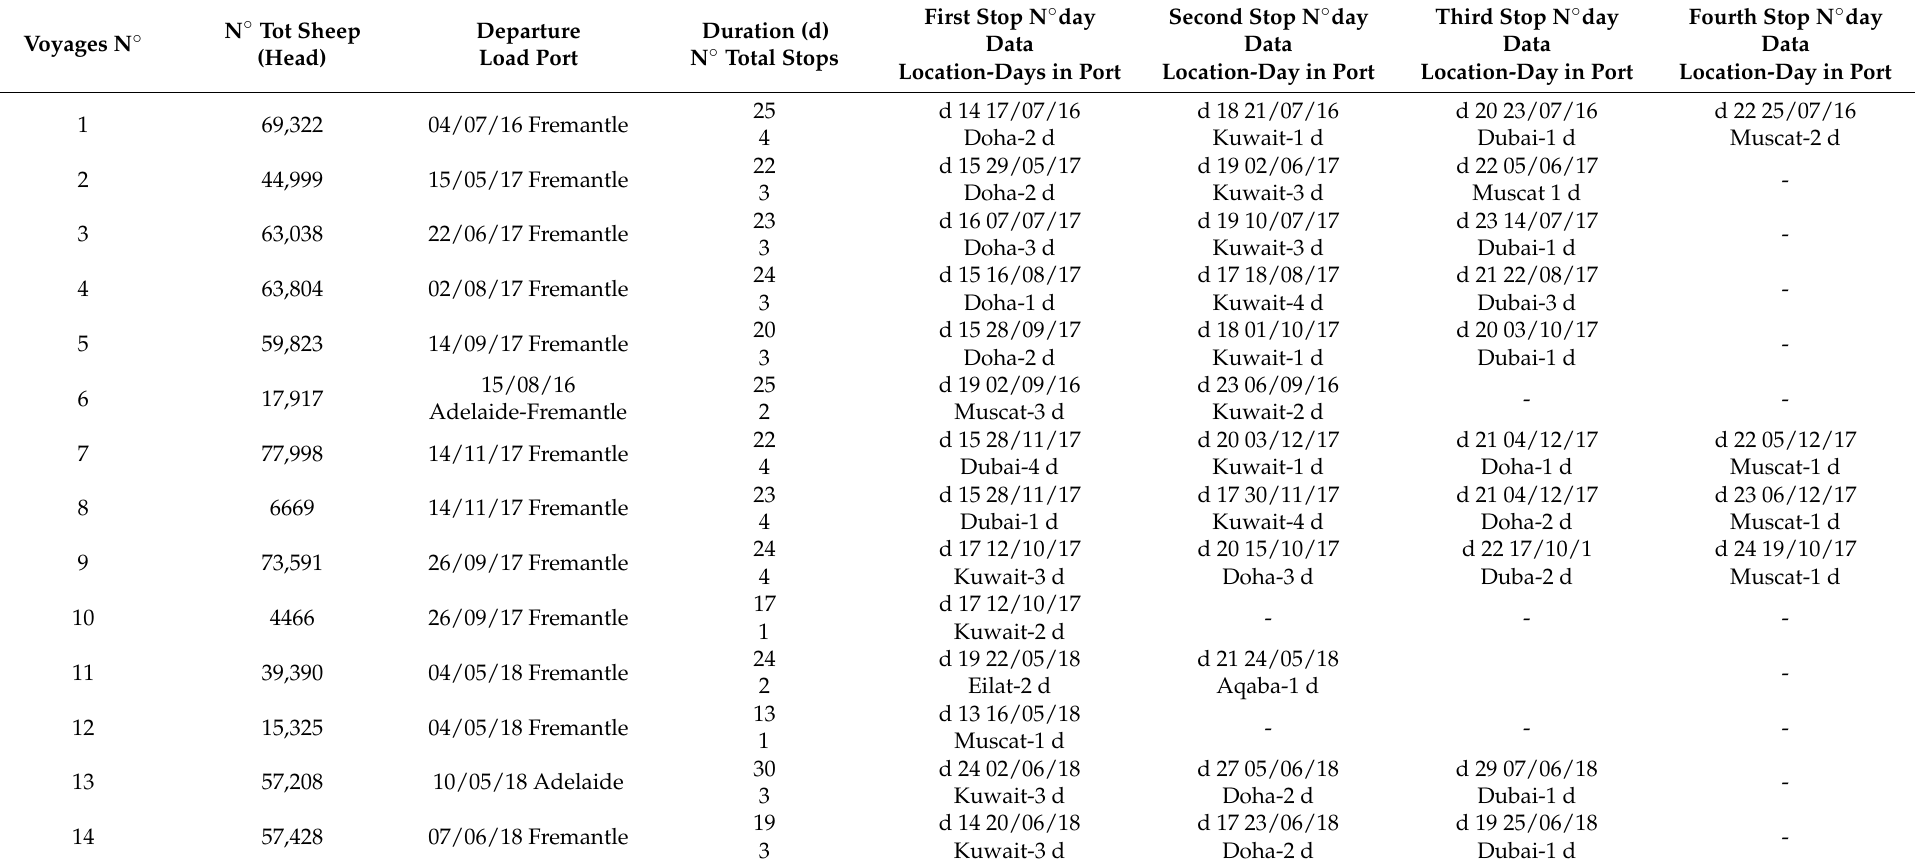
Table A1. Summary table of information relating to the 14 trips studied; duration of voyages, specifying the various ports and the time spent unloading sheep with an average of 1.95 days.